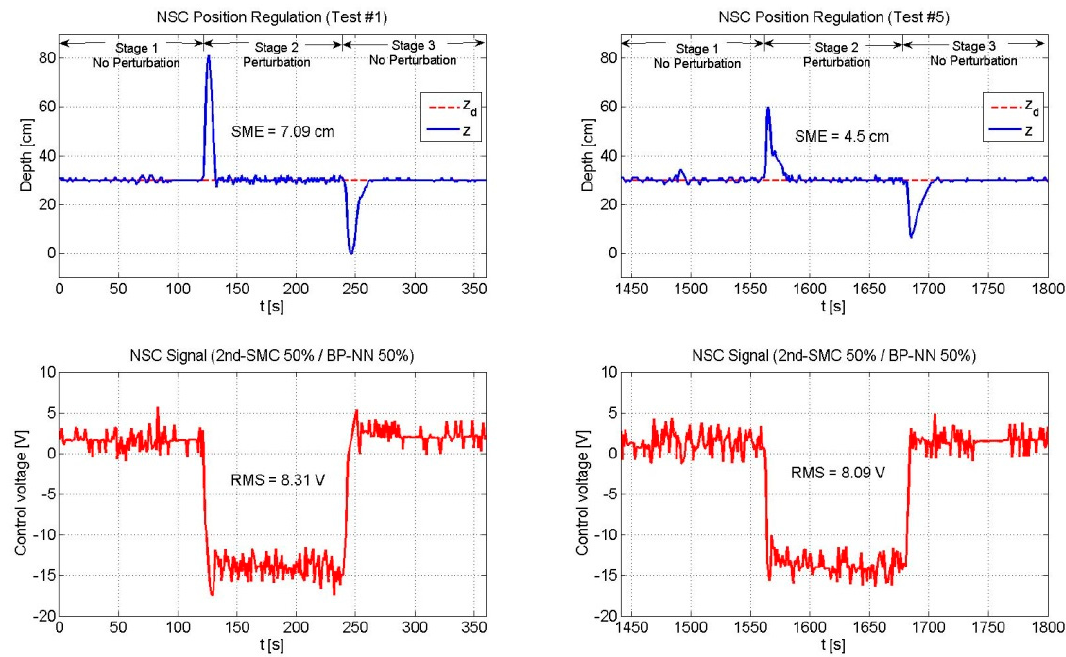
Figure 11. Performance of the NSC scheme (2nd-SMC 50%/BP-NN 50%). The overshoot showed a reduction and the BP-NN gradually reduced the SME value.